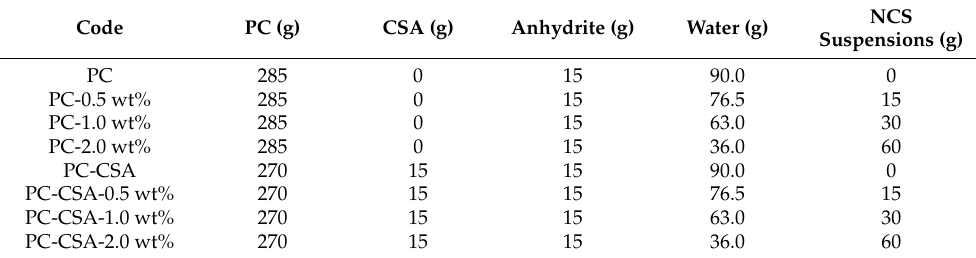
Table 4. The amounts of different components in the compressive strength